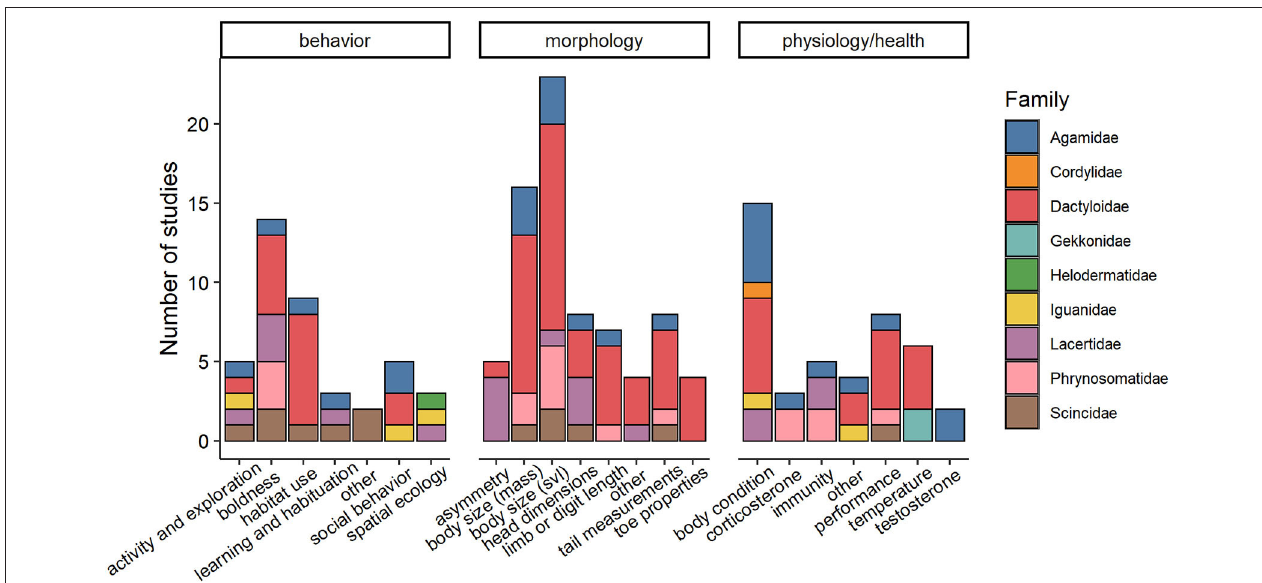
FIGURE 2 | Number of studies on urban lizards categorized by type of phenotypic trait and by family ( N = 54 articles; each article may have more than one study). Only a few behavioral, morphological, and/or physiological traits have been quantified and within only nine lizard families. Snout-vent-length, a measure of lizard body length, is abbreviated to